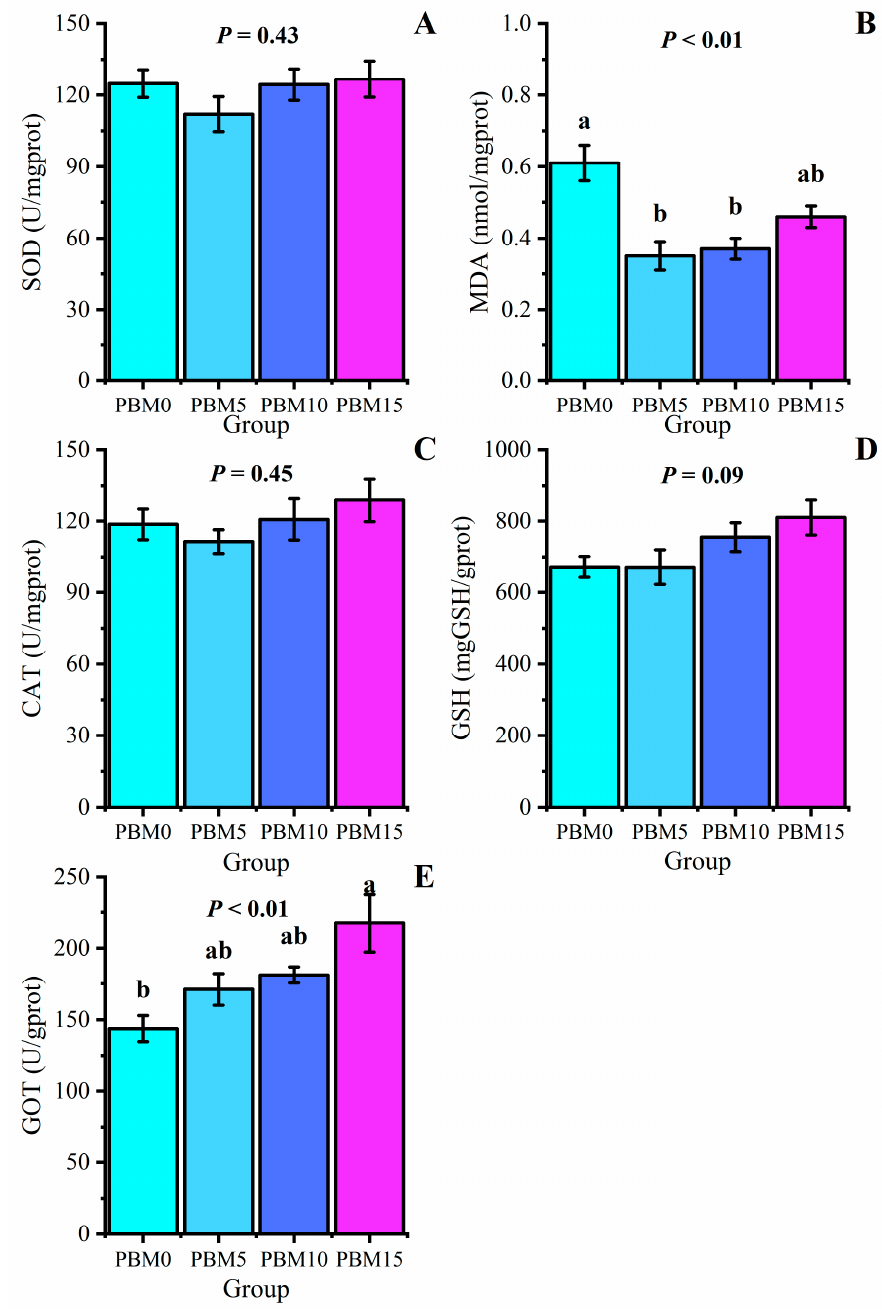
Figure 3. Effect of dietary replacement of fish meal with poultry by-product meal on the liver antioxidant of Chinese soft-shelled turtle. ( A ) Sod, superoxide dismutase; ( B ) MDA, malonaldehyde; ( C ) CAT, catalase; ( D ) GSH, glutathione; ( E ) GOT, glutamic-oxalacetic transaminase. The error bars represented the mean ± standard error (n = 6). Different letters indicated significant differences between groups ( p < 0.05).